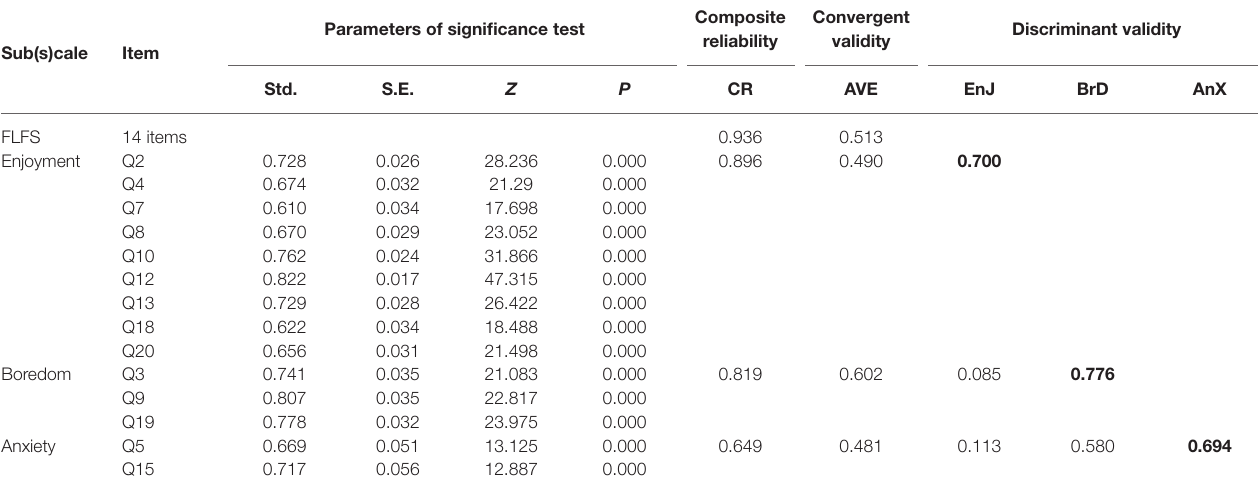
TABLE 3 | Item reliability, composite reliability, convergent validity, and discriminant validity of the FLFS and its subscales. Parameters of significance test Sub(s)cale Item